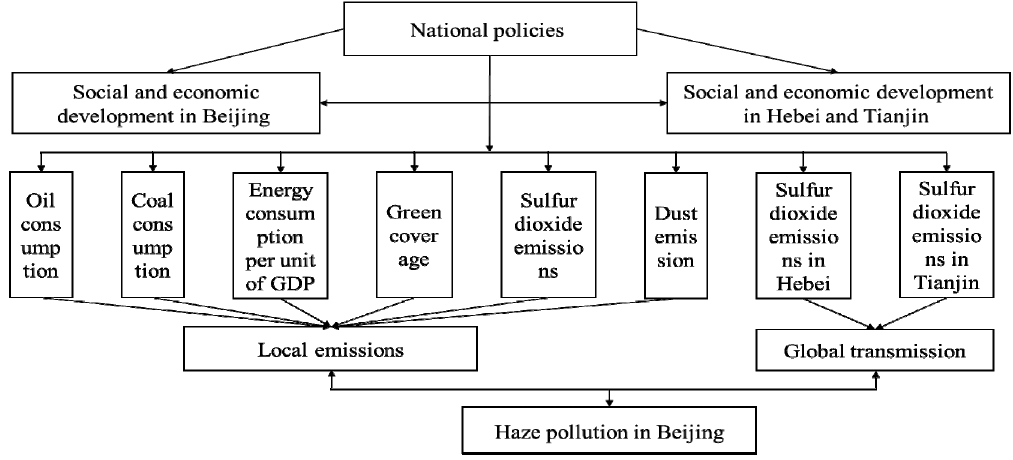
Figure 2. Structure of Beijing haze system.